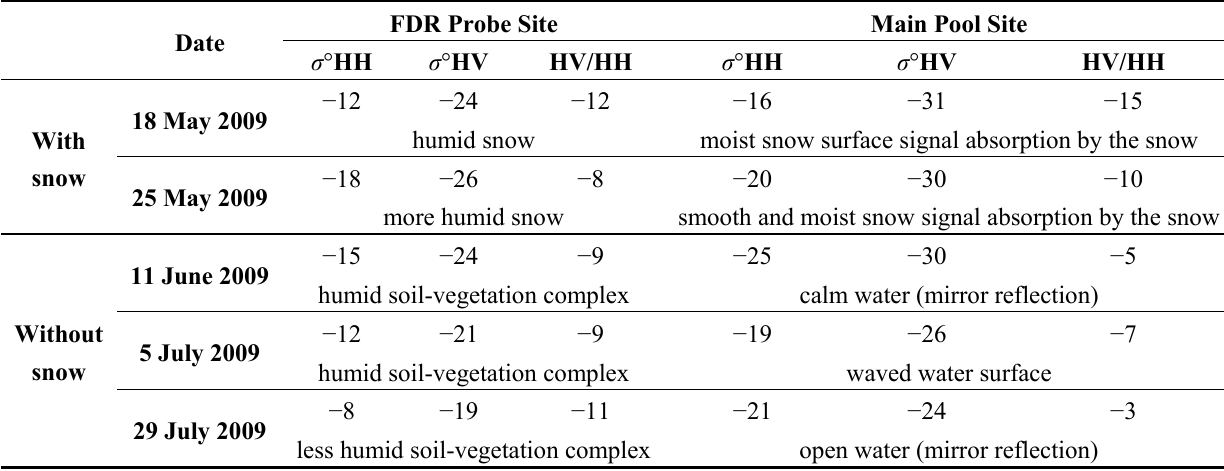
Table 6. Backscattering coefficient ( σ ° in db) for HH and HV polarization, as well as the cross-polarization ratio (HV/HH), for different sites at peatland A . IA: FQ16 (36°) and FQ20